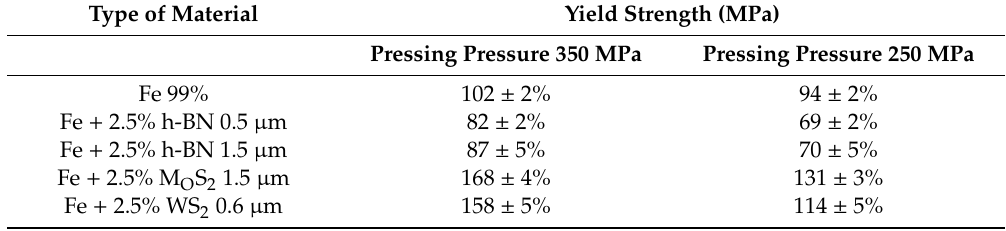
Table 4. A comparison of average measurement results of the yield strength.